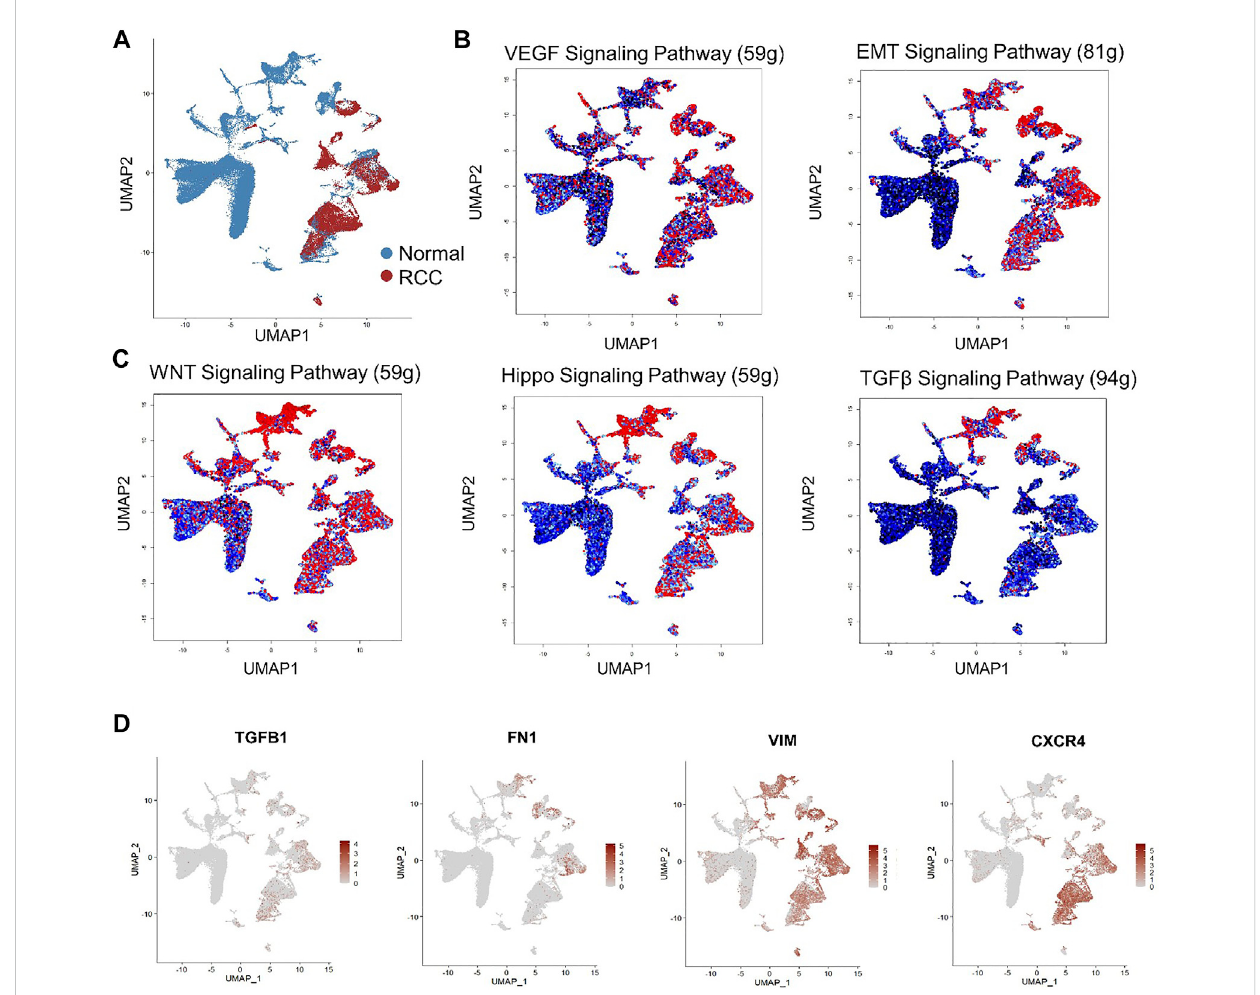
FIGURE 1 Single-cell RNA sequencing (scRNA-seq) reveals activated fi brotic signaling pathways in human renal cell carcinoma. (A) Non-linear dimensionality reduction on Uniform Manifold Approximation and Projection (UMAP) visualization of renal cells from RCC patients and the healthy control group. Each pointdepictsasinglecell,coloredaccordingtogroupdesignation.ColoredUMAPplotsofhighlightedcellswithactivatedgenesetexpressionin (B) VEGF and EMT signaling and (C) WNT, Hippo, and TGF- β signaling pathways in renal cells based on AUC scores. Each point represents a single cell. Cells with indicated signaling activation are colored in shades of red and those without signaling activation are colored in black – blue. (D) UMAP plots of gene expressiongradientsidenti fi ed.Eachpointdepictsasinglecell,coloredaccordingtonormalizedexpressionlevels.Theaverageexpressionscaleisshown on the right side of each UMAP